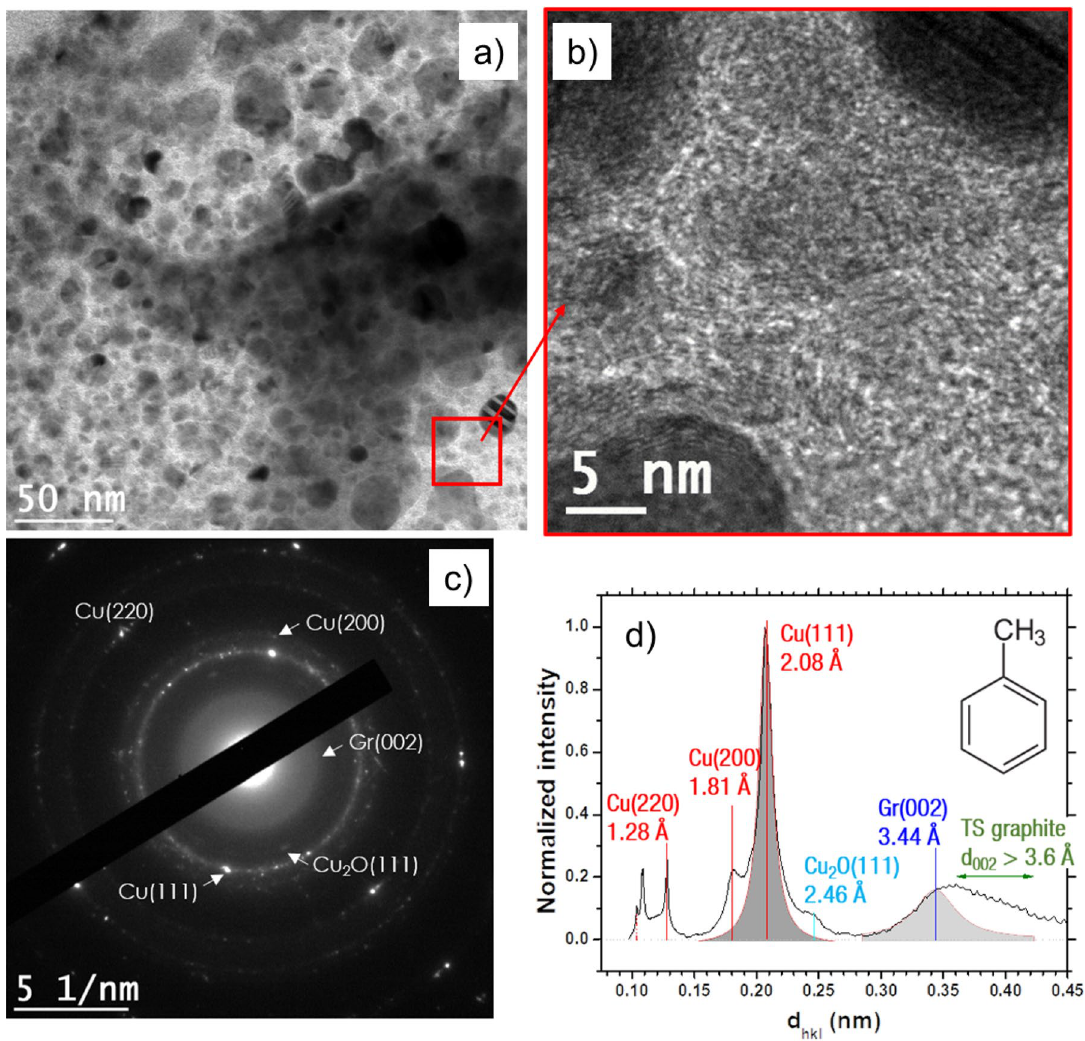
Figure 3. ( a ) High-resolution image of Cu nanoparticles embedded in a carbonaceous matrix synthesized by discharges in toluene. ( b ) HRTEM image of the red inset of ( a ) showing Cu nanoparticles (black) and nanocrystalline carbon. ( c ) SAED pattern from ( a ) radially integrated into ( d ), which mainly indicates pure Cu features with a nanocrystalline graphite